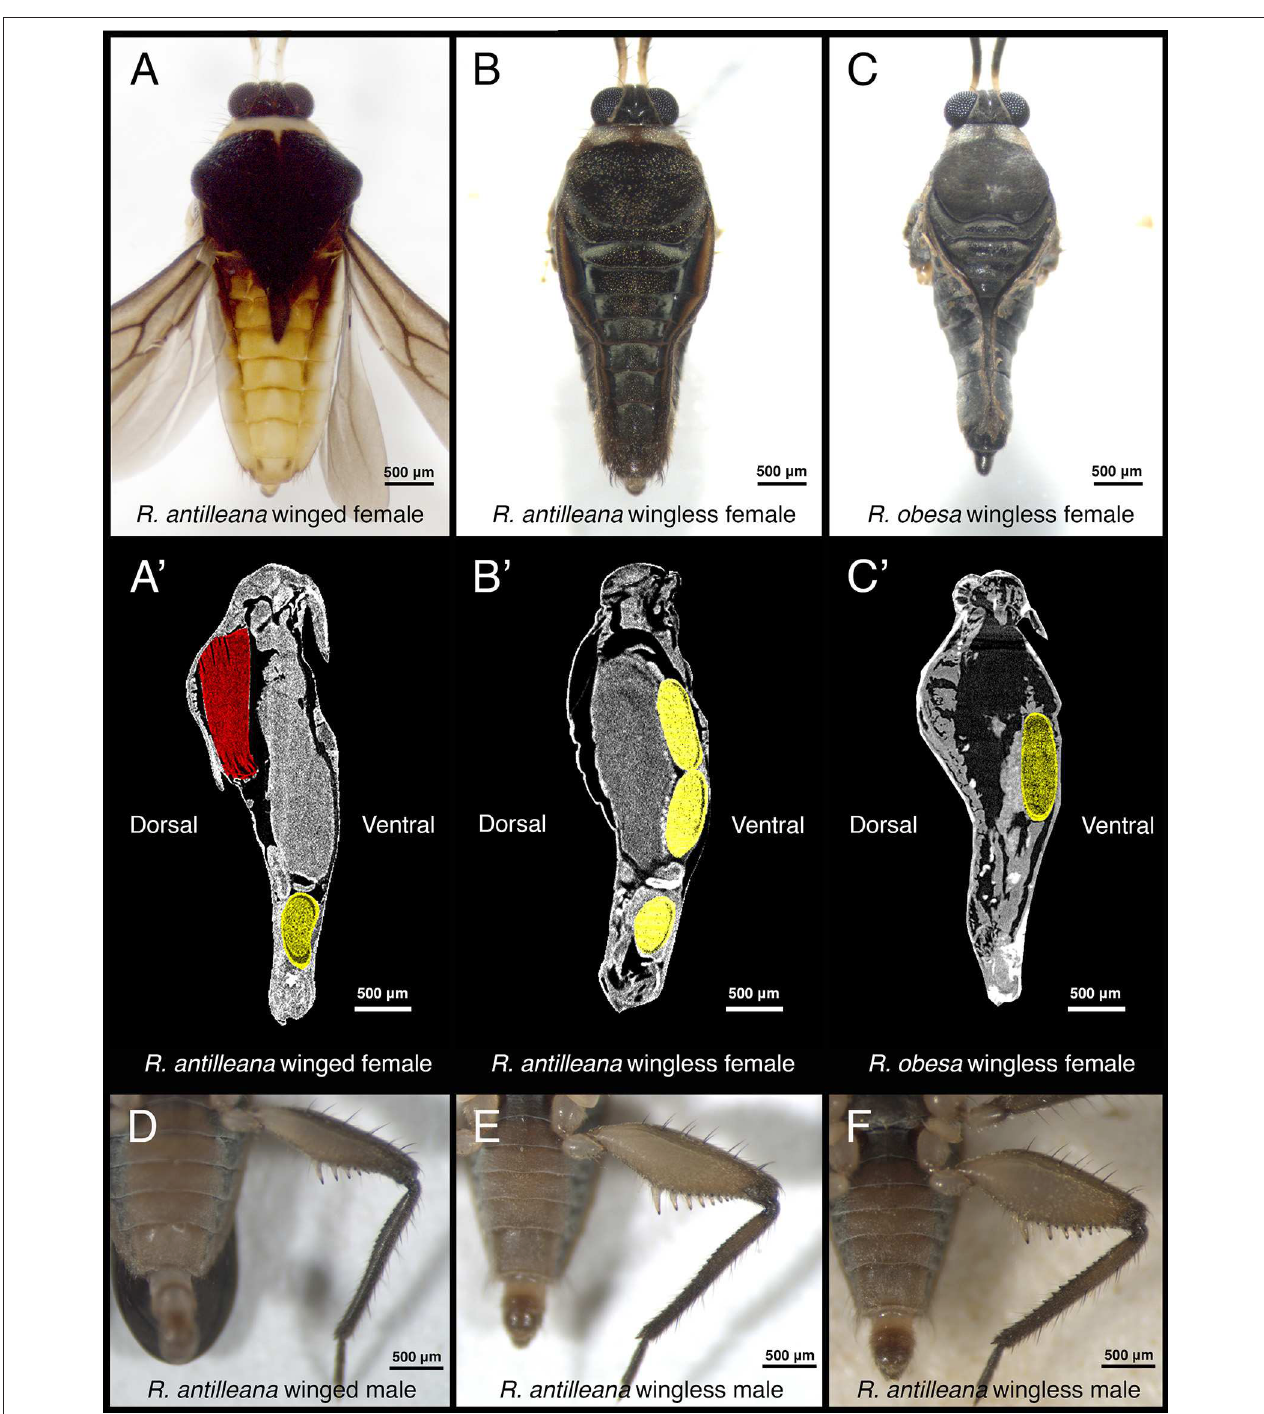
FIGURE 2 | Variation in secondary sexual traits in Rhagovelia . Winged R. antilleana females (A) have a large abdomen compared to wingless females (B) . The presence of wing muscles ( A’ , in red) in the thorax constrains the eggs to be located in the abdomen (in yellow) while in wingless females (B’) the space in the thorax is free from wing muscles and can be occupied by eggs, thus allowing a narrow abdomen. In species such as R. obesa (C) , the narrow abdomen is even more pronounced and eggs are located in the thorax (C’) , thus confirming our observation. There is also variability in the rear-leg in males, especially in the size of the femur. Winged males (D) , have thin femurs while other males have intermediate (E) or large femurs (F) .